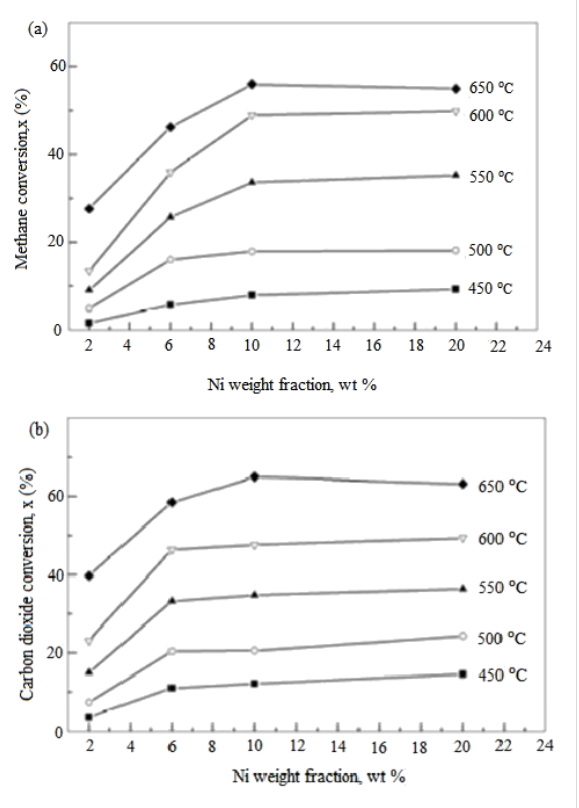
Figure 14: The effect of reaction temperature on catalyst performance: (a) CH 4 conversion, (b) CO 2 conversion, at feed ratio CH 4 /CO 2 1:1,